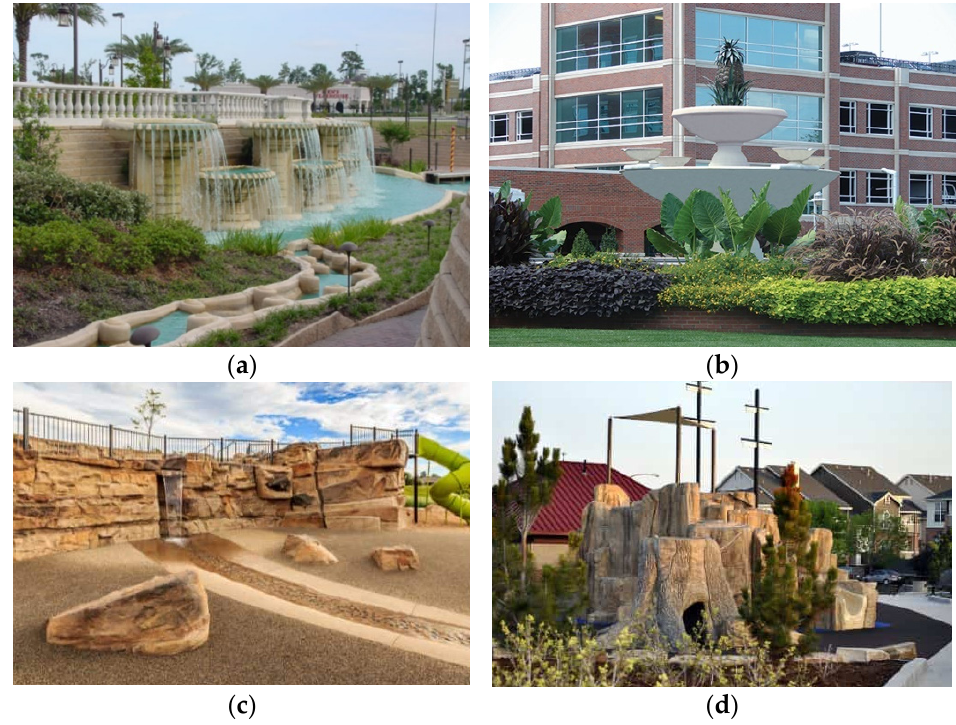
Figure 37. ( a , b ) GFRC fountain [144,145]; ( c ) Mehaffey Park in Loveland in Colorado, USA [146]; ( d ) Center Park in Westminster in Colorado, USA [147].